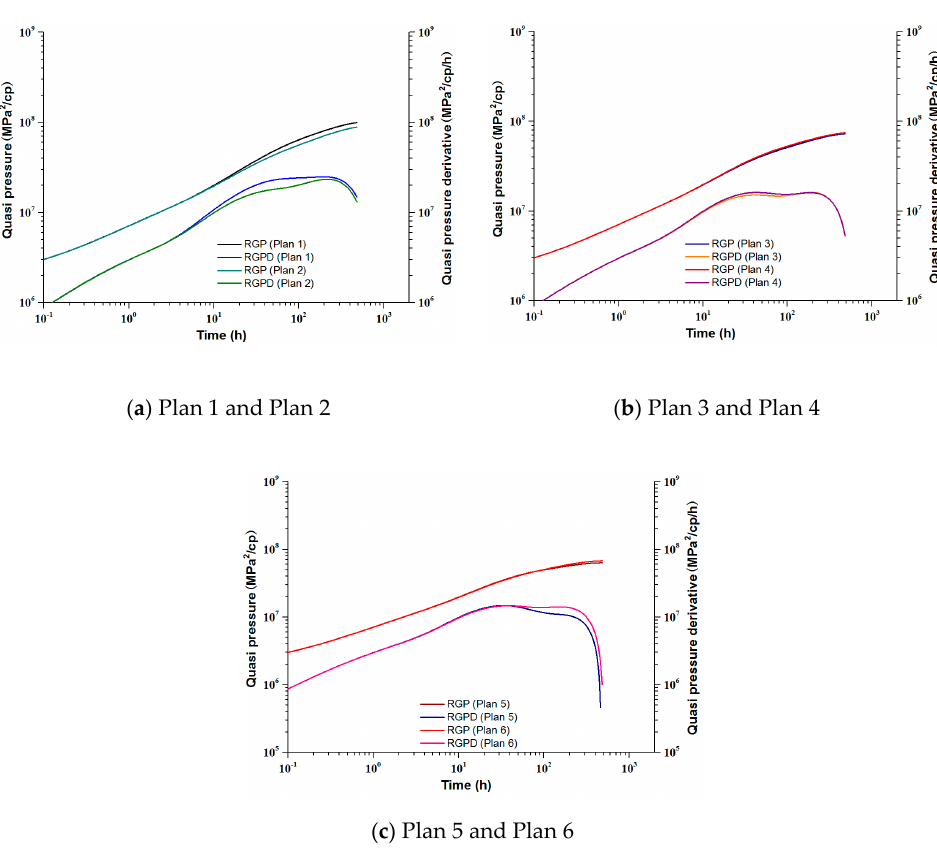
Figure 14. Double logarithmic curve of pressure recovery of shut-in wells under different well pattern and multiple neighboring wells.